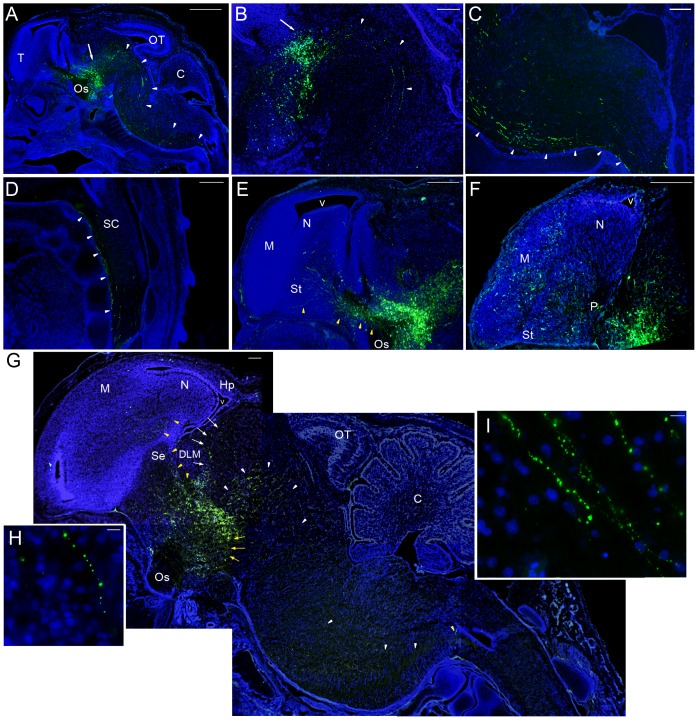
Zebra finch GFP positive cells project into chimeric quail hindbrain and zebra finch forebrain.Embryos are shown with GFP-electroporated zebra finch cells stained with a GFP antibody (green), and all tissue counterstained with DAPI (blue). (A) Chimera brain section at low magnification illustrates GFP stained cells (white arrows) located in the thalamus and GFP positive fibers (white arrowheads) in the spinal cord. (B) Chimera sections in the midbrain area showing the GFP positive fiber tract (thalamic-spinal cord tract) from the thalamic neurons. (C) GFP positive fibers in the quail medulla. (D) GFP positive fibers in the quail spinal cord at higher magnification. (E) GFP positive fibers (yellow arrowheads) in the zebra finch telencephalon passing through the lateral forebrain bundle. (F) GFP positive fibers in the telencephalon, including the pallidum, stratum, nidopallium, and mesopallium. (G) Montage of ED12 chimera brain sections shows the four main tracts of GFP-stained cell fibers: thalamic-spinal cord tract (white arrowheads), thalamic-forebrain tract (yellow arrowheads), thalamic-hypothalamus tract (yellow arrows), and thalamic-habenula tract (white arrows). (H) High magnification view showing GFP positive fibers in finch tissue. (I) High magnification in quail tissue. Panels (A–E) are at ED 9 and (F–I) at ED12. Scale bars = 1 mm in A, 250 µm in B–D, 500 µm in E–F, 200 µm in G and 10 µm in H–I.